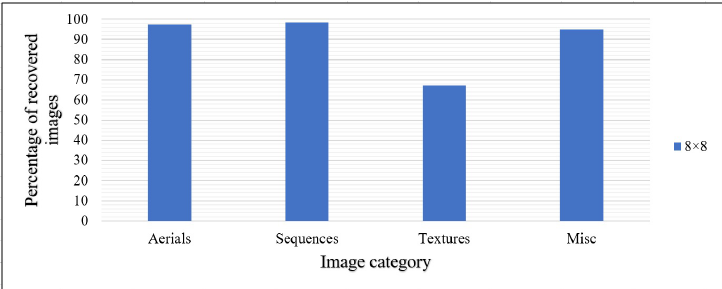
Figure 7. Rate of images recovered.